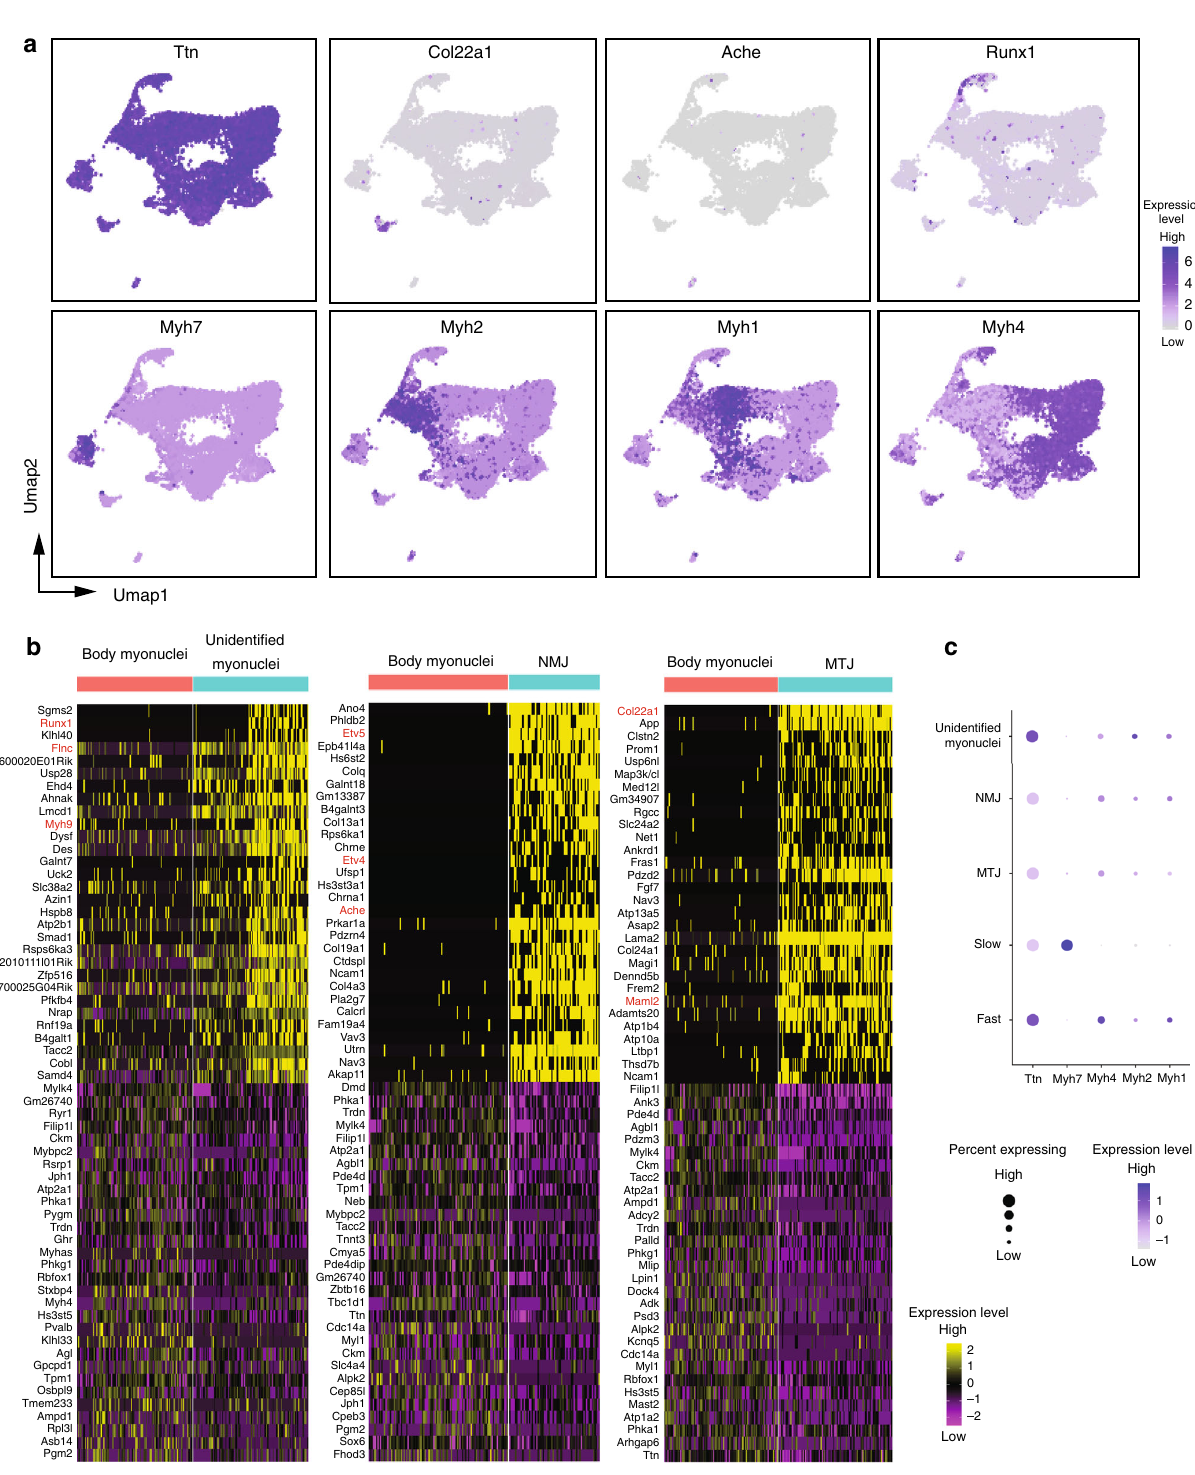
Fig. 2 The different populations of myonuclei. a Umap Plots showing the expression of several markers used to identify the different types of myonuclei. The intensity of the blue color re fl ects the level of expression of the gene. b Heatmap of the top 30 genes upregulated and downregulated (yellow) in body myonuclei versus unidenti fi ed myonuclei (left), in body myonuclei versus NMJ nuclei (center), and body myonuclei versus NMJ nuclei (right). The values correspond to z -scores of normalized counts. c Dot-plots from snRNA-seq experiments showing the expression of the slow and fast Myh in the different populations of myonuclei. NMJ and MTJ nuclei expressed Myh like other